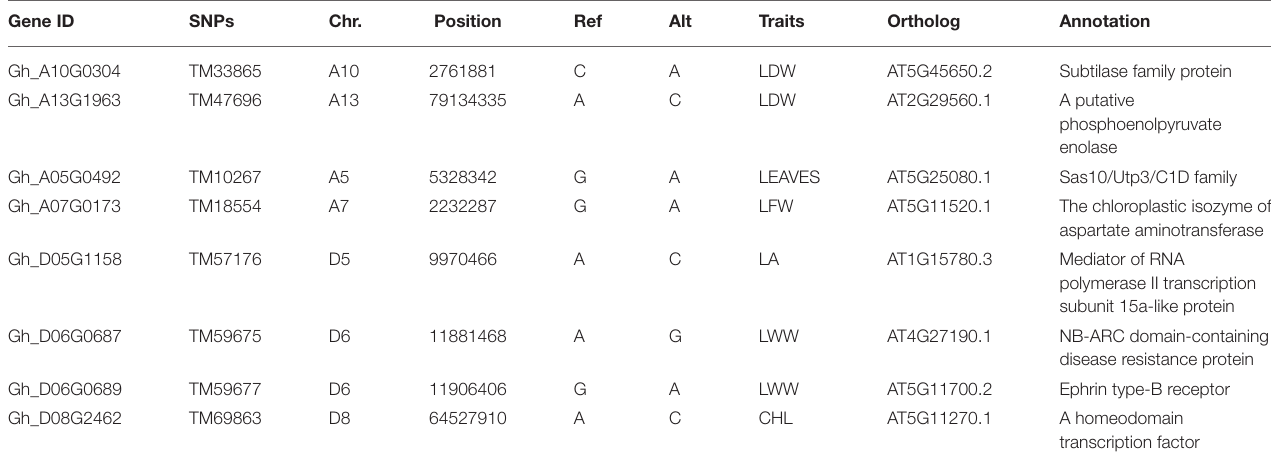
TABLE 4 | Candidate genes that include significantly associated SNPs for traits involved in drought